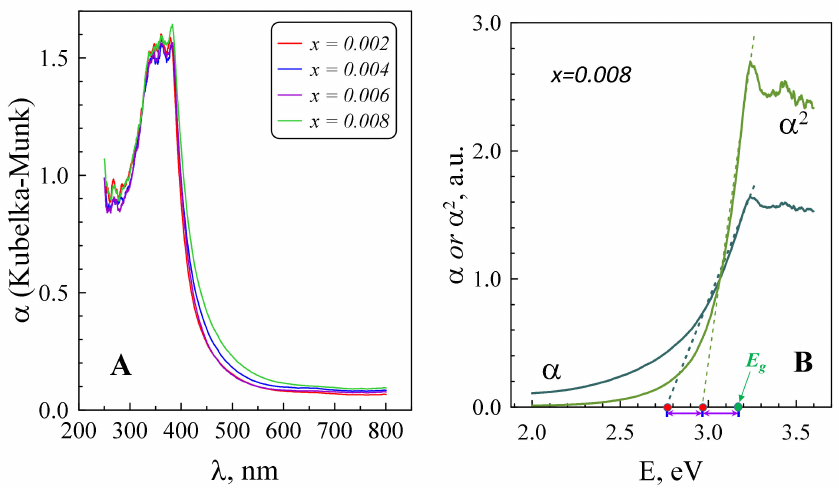
Figure 6. Di ff use reflectance spectroscopy (DRS) spectra of the prepared materials, represented through absorption coe ffi cient α (Kubelka–Munk formalism) ( A ) and representative example for the band gap calculation by a method adopted in [34] ( B ). Corresponding DRS spectrum for pristine material can be found elsewhere